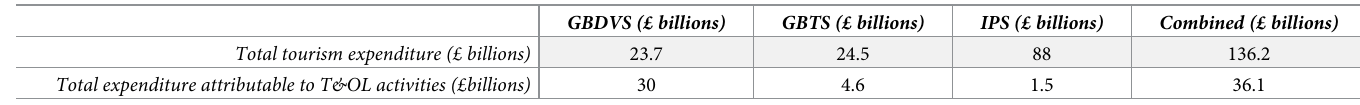
Table 3. Tourism expenditure. Total tourism expenditure from each survey and the amount attributable to T&OL